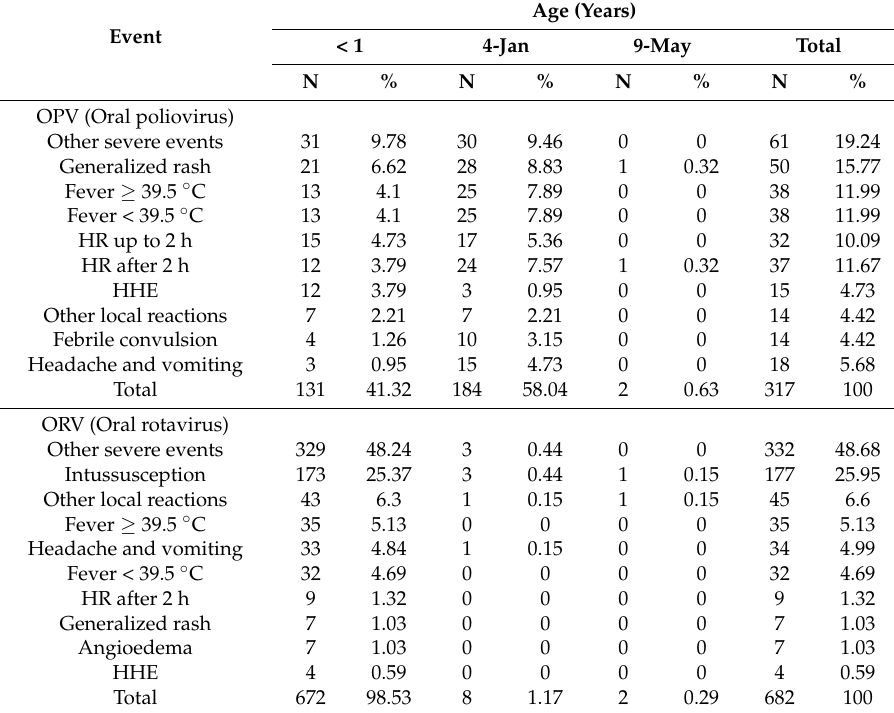
Table 3. Frequency of occurrence of the 10 most reported adverse events related to the oral vaccines by age groups, considering only single inoculation